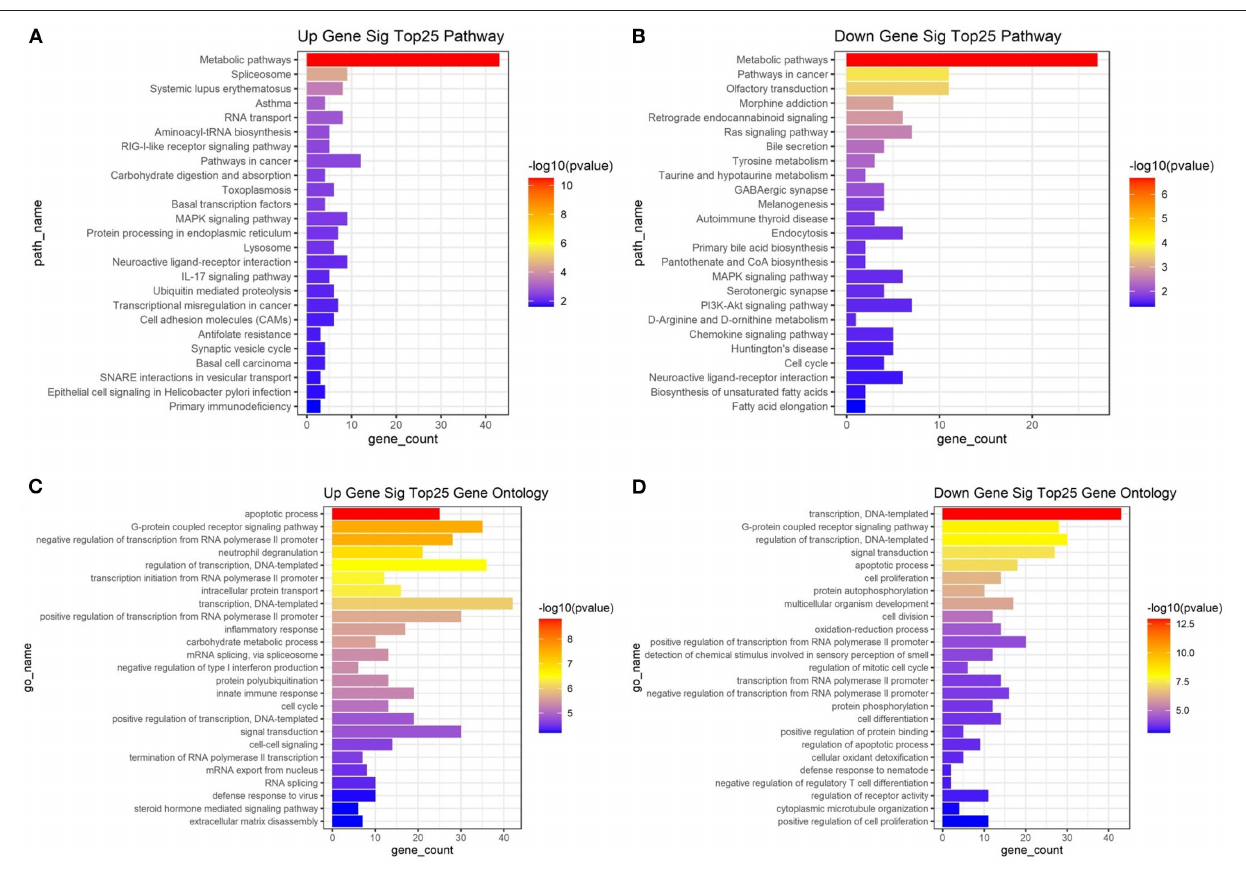
FIGURE 3 | Kyoto Encyclopedia of Genes and Genomes (KEGG) pathway enrichment analysis of the top 25 up (A) /down (B) -regulated pathways enriched in differentially expressed genes between high/low BMD subjects. Top 25 up (C) /down (D) -regulated biological processes enriched in differentially expressed genes between high/low BMD